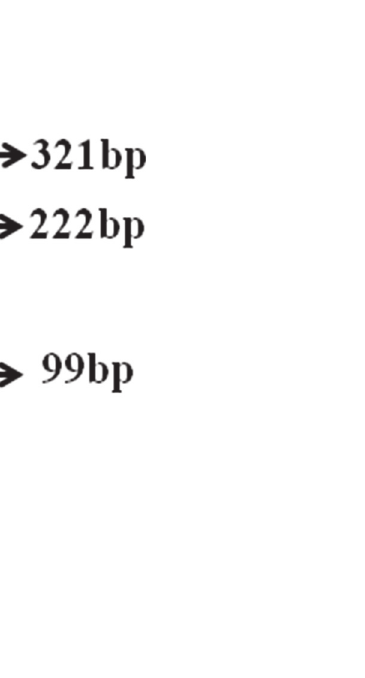
Fig 1. RFLP analysis of the G/A polymorphism in the promoter region of the Mcp-1 gene.